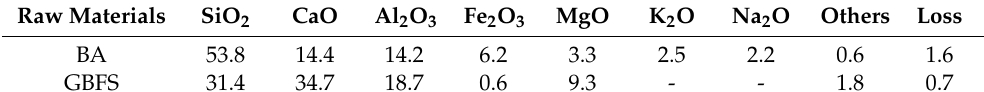
Table 1. XRF spectroscopy detection of raw materials (%).